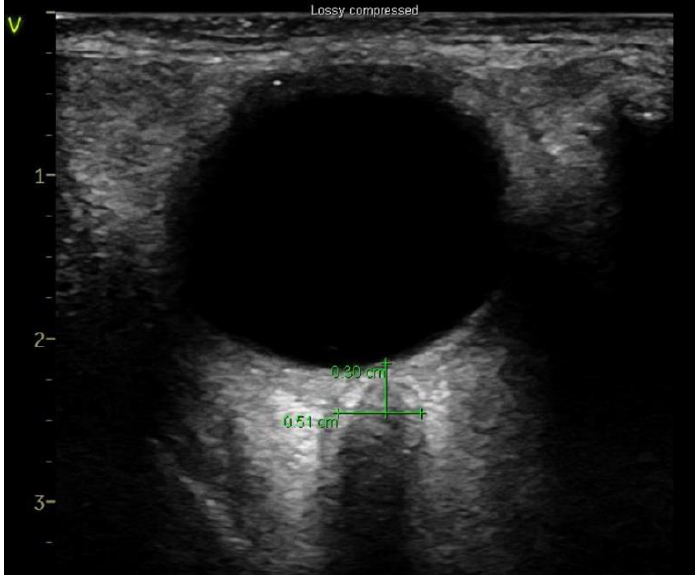
Figure 1. Sonographic optic nerve sheath diameter (ONSD).